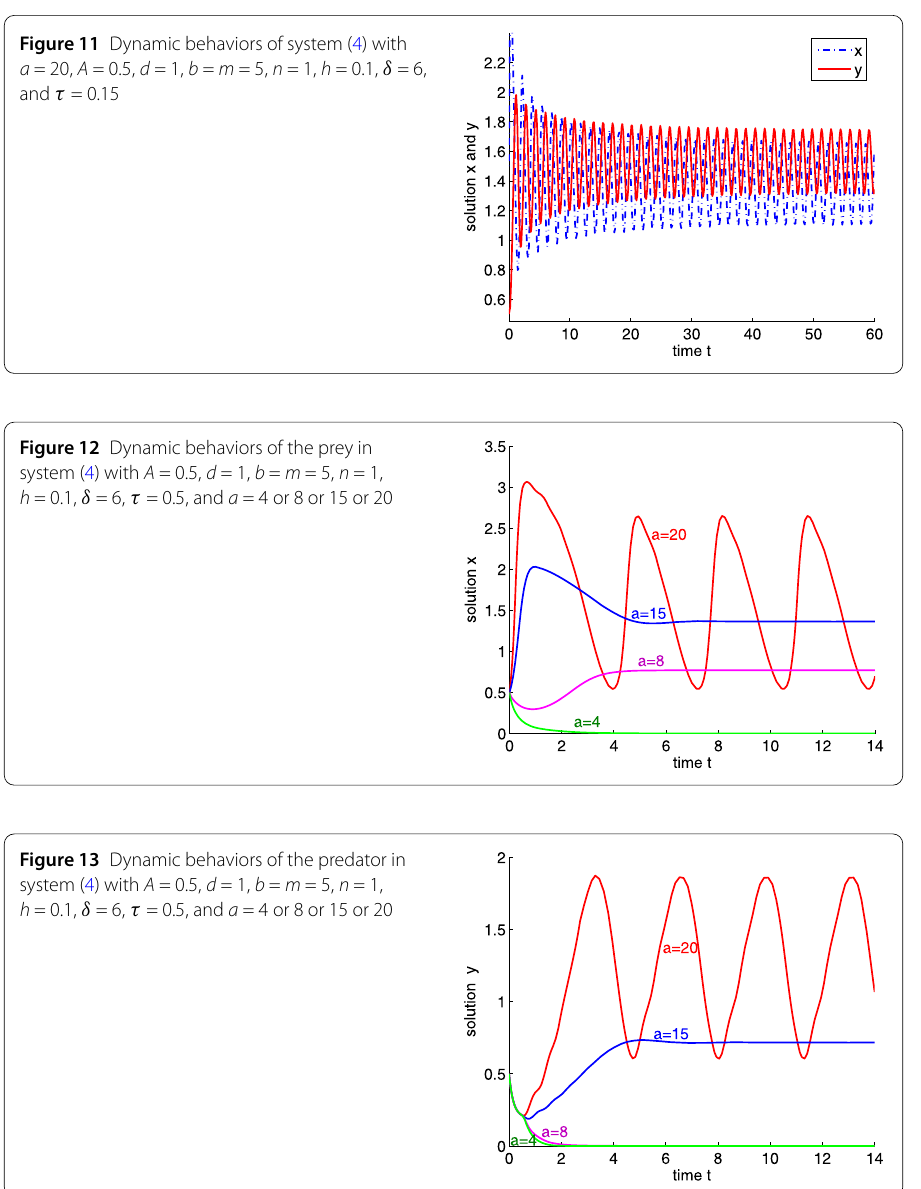
Figure 11 Dynamic behaviors of system (4) with a = 20, A = 0.5, d = 1, b = m = 5, n = 1, h = 0.1, δ = 6, and τ = 0.15